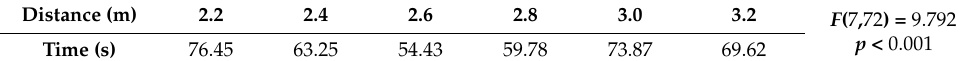
Table 6. Time data after the depth distance range of the accurate identification information is divided.